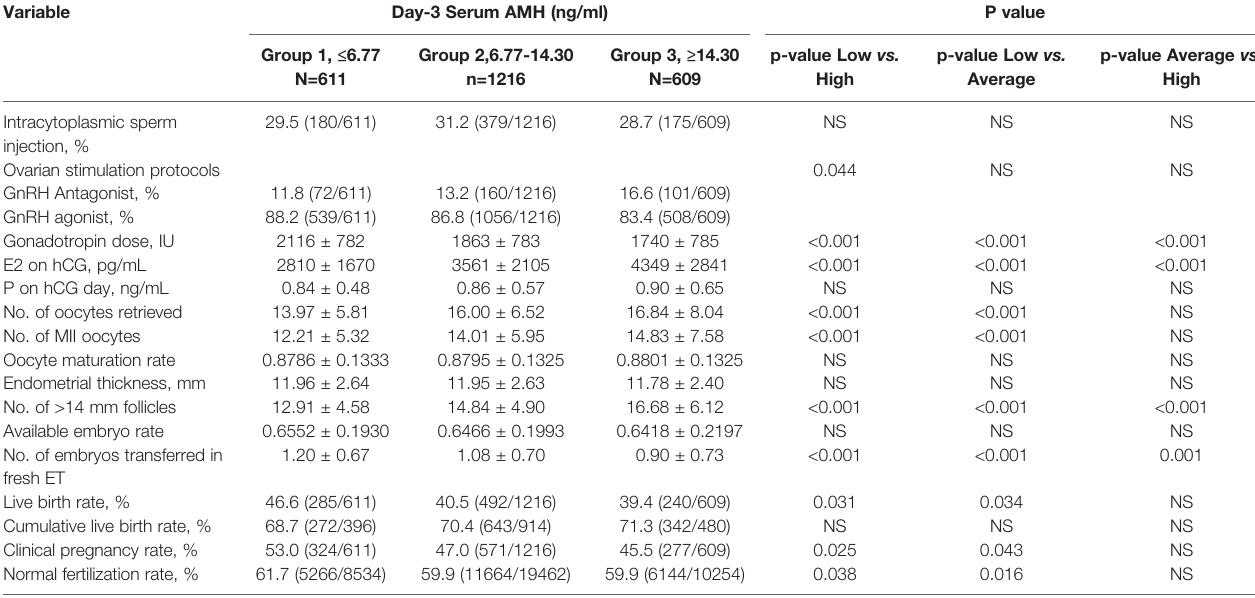
p-value Low vs. p-value Low vs. High Average